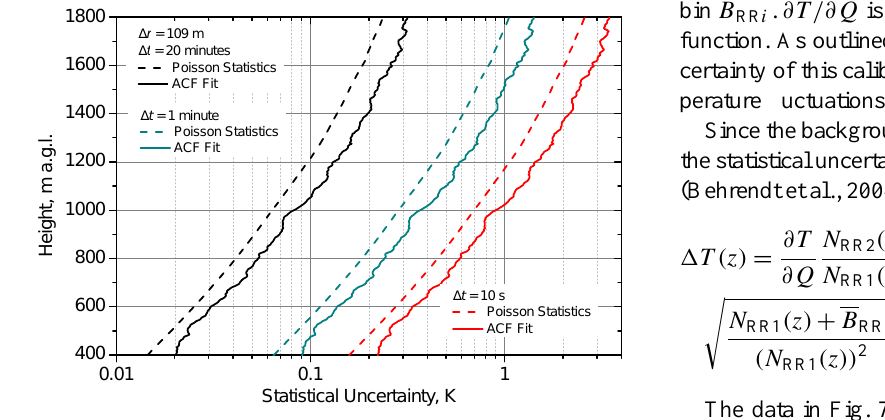
Figure 7. Statistical uncertainties of 10s, 1min, and 20min tem- perature profiles at noontime determined with a 2 / 3-power-law fit of the ACF data (see Fig. 6). Shot-noise errors calculated by use of Poisson statistics from the detected signal intensities in each height are shown for comparison. It can be seen that the statistical uncer- tainty of the RRL temperature measurements is mainly governed by shot noise. The range resolution of the data was